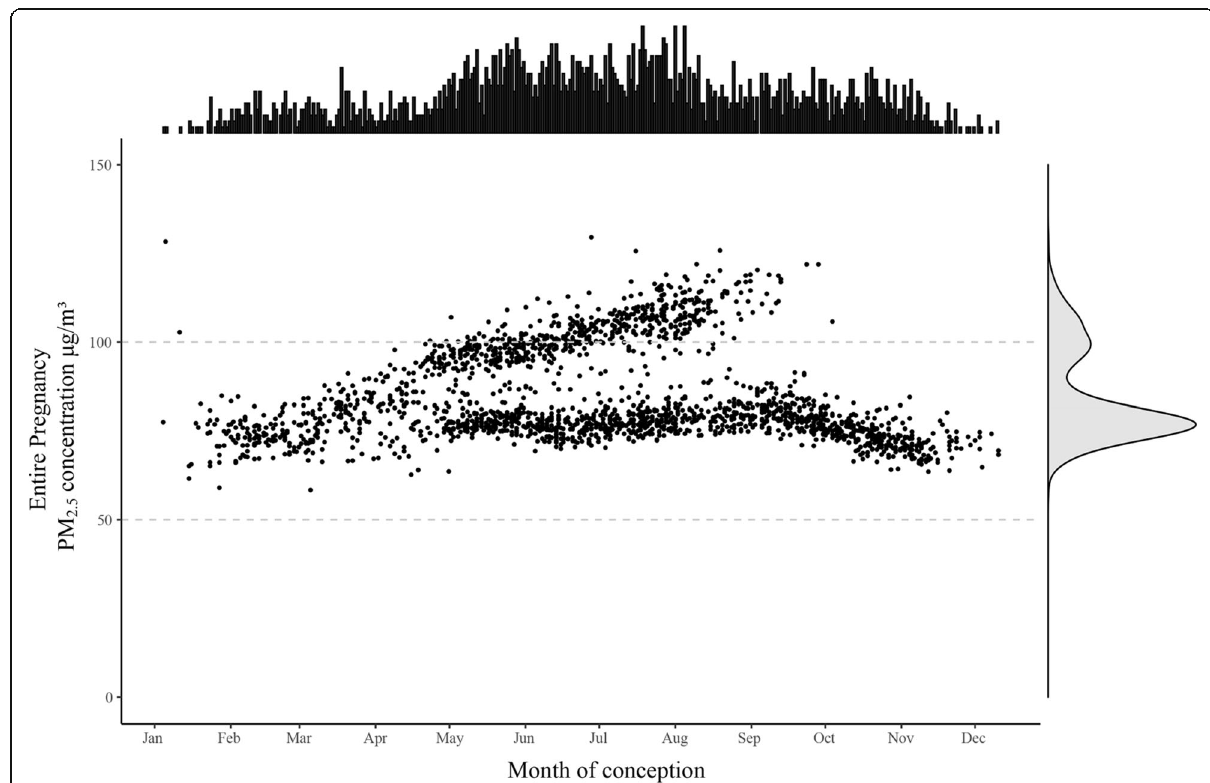
Fig. 3 Distribution of months of conception for participants and individual PM 2.5 exposure in the specific trimester. Notes: The height of the bar indicates the number of participants. The dot indicates the woman who exposure to a specific PM 2.5 concentration. The density plot on the right marginal of y-axis visualizes the distribution of the number of subjects over the PM 2.5 concentration intervals